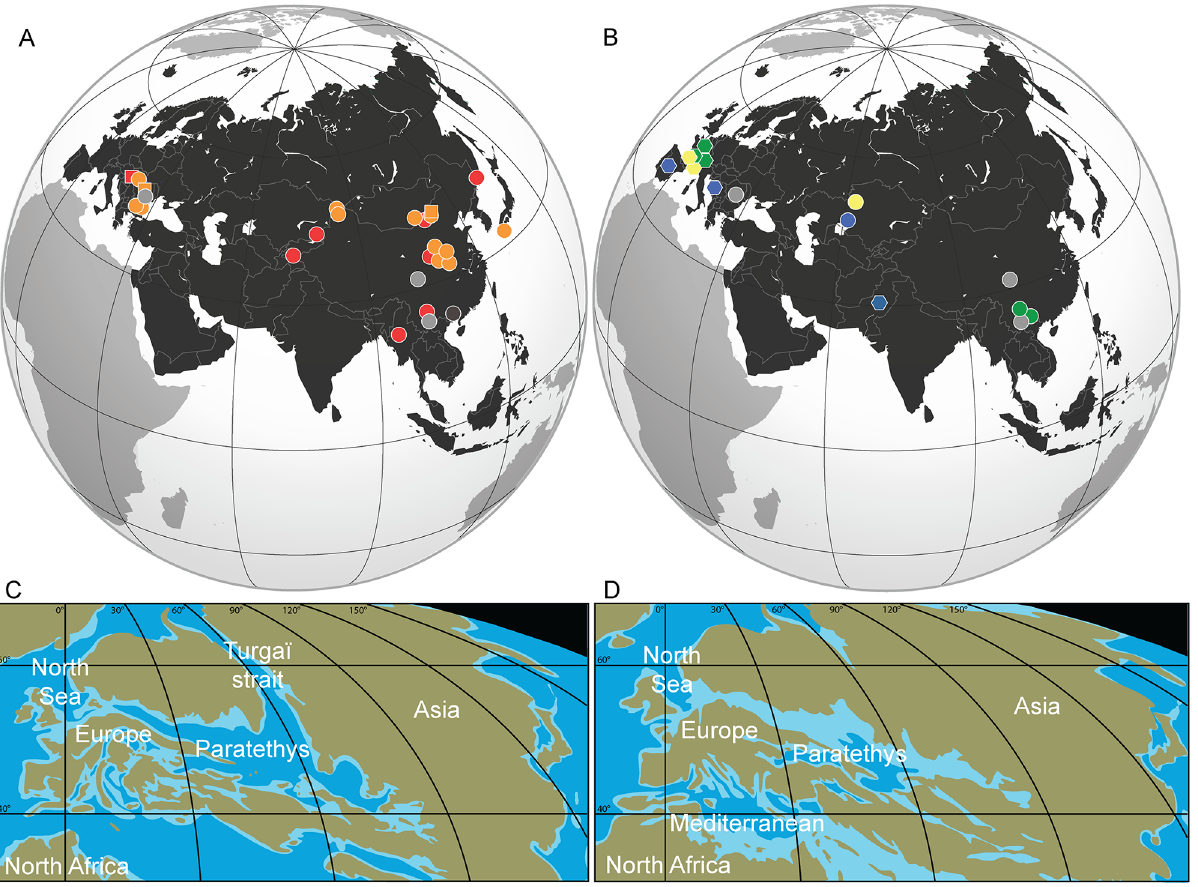
Fig 9. Distribution maps of Amynodontidae and palaeogeographical map reconstructions in Eurasia. Middle to Late Eocene (A) and Oligocene (B) fossil localities bearing amynodontids. See Table 4 for symbols and colours explanations as well as localities and occurrences references. Palaeogeographical map reconstructions during the Late Eocene (C) and Early Oligocene (D) modified from Ron Blakey (jan.ucc.nau.edu/rcb7/ mollglobe.html).